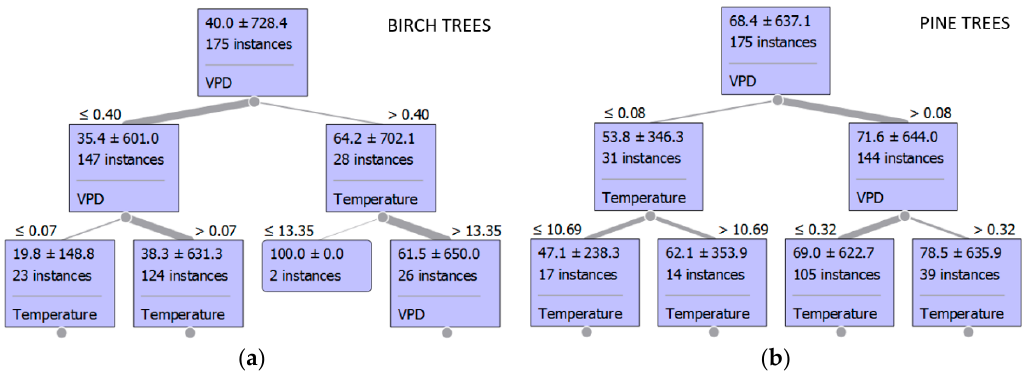
Figure 6. Decision trees for rainfall interception by birch ( a ) and pine ( b ) trees; only the first three levels are presented. Values shown in boxes indicate mean and variance of instances related to this specific node. Numbers written outside boxes indicate values that are used to divide different nodes.